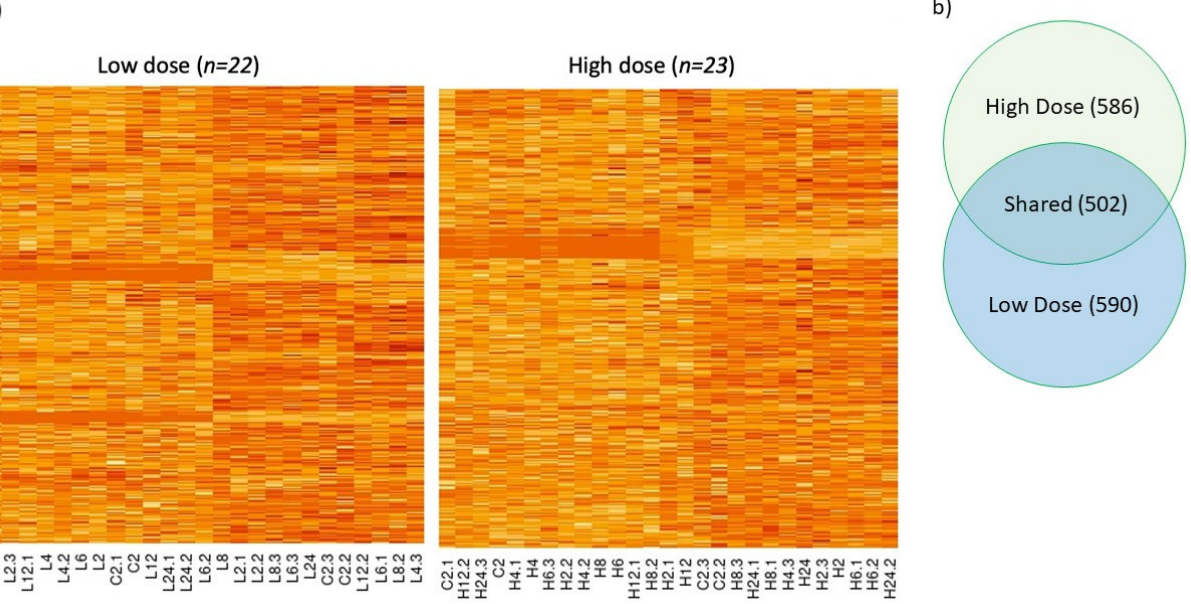
Figure 1. ( a ) Heat map depicting transcript abundance in the boll weevil across a 24 h time course (0, 2, 4, 6, 8, 12, and 24 h) following exposure to a low and high concentration of malathion. The color scheme indicates the gradient from high to low transcript abundance, where dark red coloring indicates the most transcripts and light yellow indicates the least while rows represent genes and columns represent individuals at time points. ( b ) Venn diagram of shared and unique genes in the low and high concentration treatment. The high concentration had a total of 1088 genes that changed significantly over the time series and 1092 in the low concentration. There were 502 genes shared between the low and high concentration.